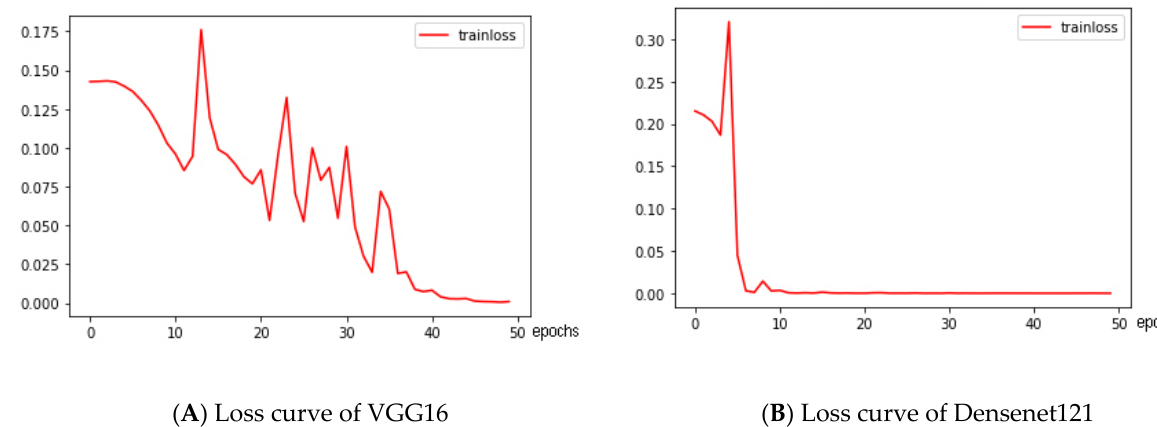
Figure 7. Loss curves of deep learning models.